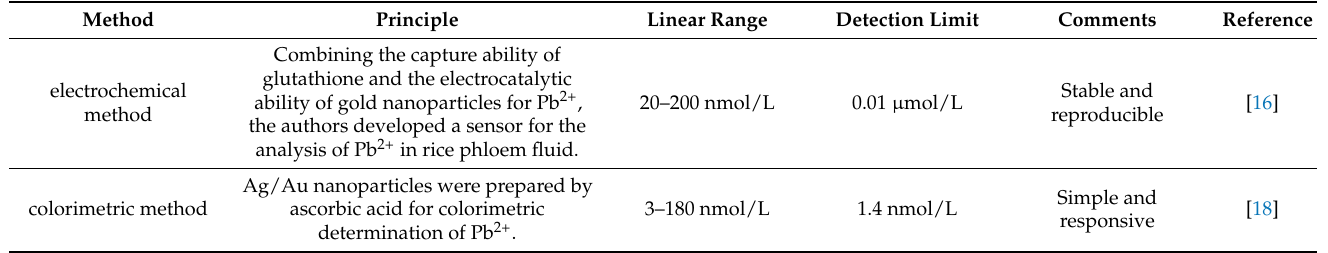
Table 2. Comparison with the reported Pb 2+ analysis